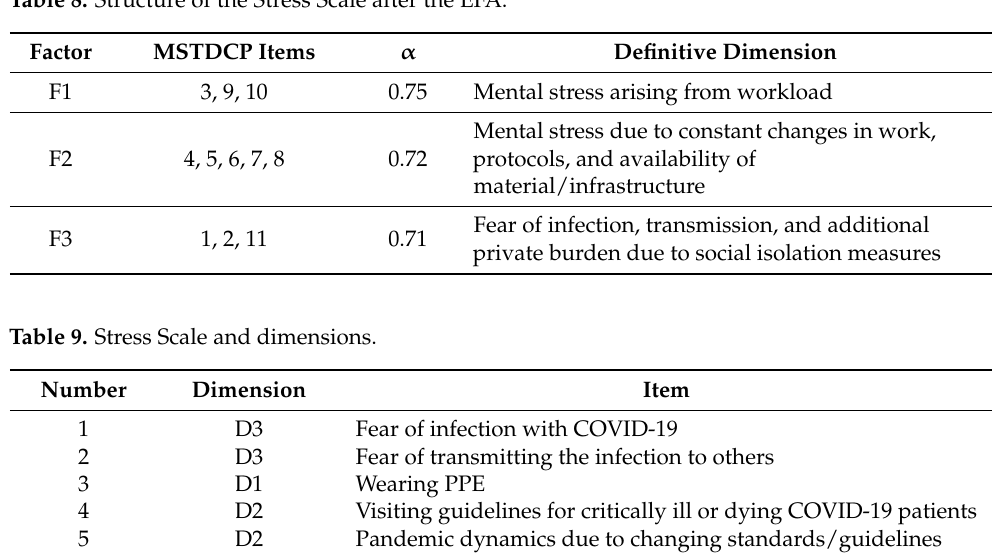
Table 8. Structure of the Stress Scale after the EFA.